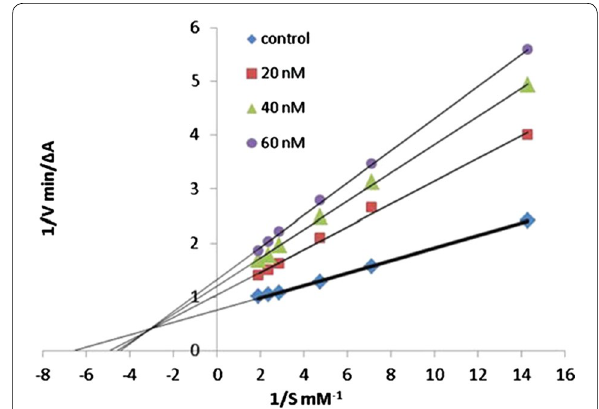
Fig. 51 Kinetic study on the mechanism of AChE inhibition by compound C46 . Overlaid Lineweaver–Burk reciprocal plots of AChE initial velocity at increasing substrate concentration (0.05–0.50 mM) in the absence of inhibitor and in the presences of different concentrations of C46 are shown [55]